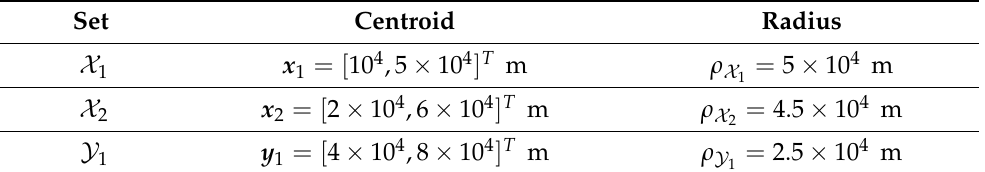
Table 1. Parameters describing the sets X 1 , X 2 and Y 1 considered in the experimental